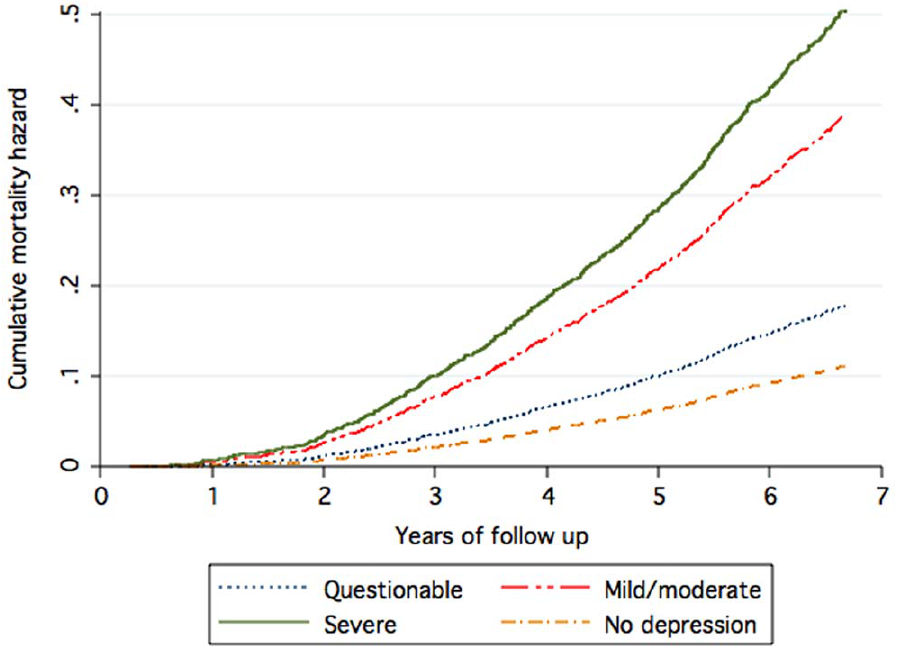
Figure 2. Cumulative mortality hazard over time (in years) associated with the severity of depressive symptoms (adjusted for all measured demographic and lifestyle factors as well as comorbidities listed in table 1). The groups with ‘no’, ‘questionable’, ‘mild to moderate’ and ‘severe’ depression corresponded to GDS-15 total scores of 0 (n=1,166), 1 to 4 (n=3,465), 5 to 9 (n=533) and 10 or greater (n=112), respectively.